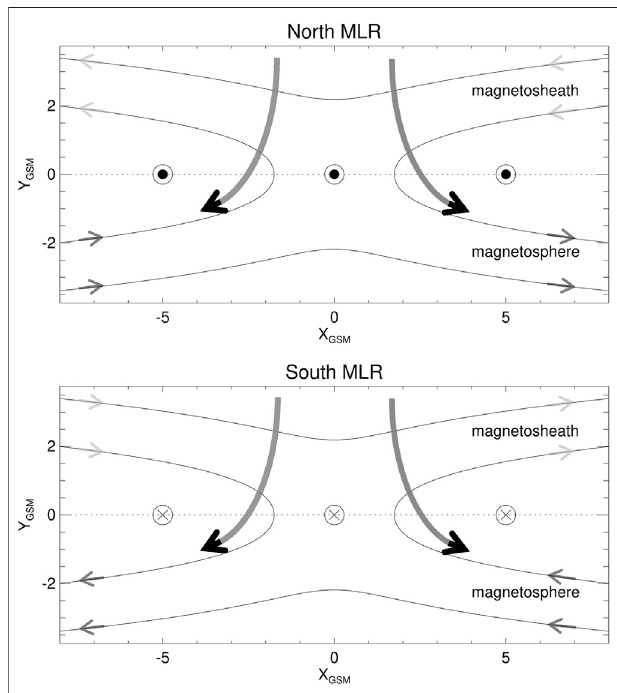
FIGURE 11 | Schematic ion entry from the magnetosheath into the magnetosphere of cold magnetosheath ions associated with KH-sheared magnetic fi eldsintheadjacentmagnetosphereandmagnetosheath.Thinsolid lines and associated arrows mark the direction of the in-plane component ofthe magnetic fi eld around the ion diffusion regions ofa northern MLR region (top) and a southern MLR (bottom) region consistent with a presence of a Jz GSM > 0 current (encircled dots at Y GSM (cid:1) 0) in the north and